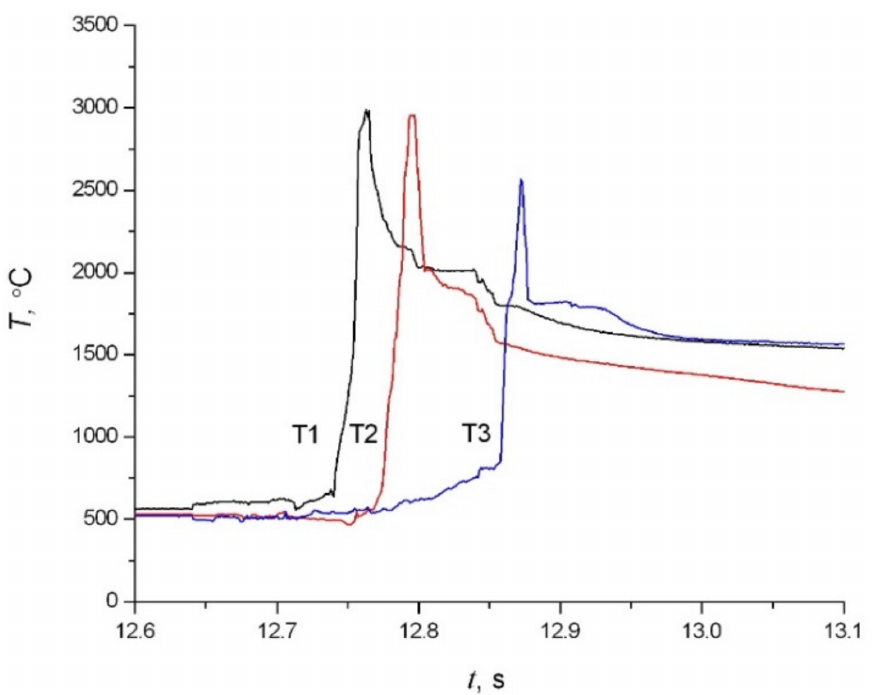
Figure 2. Readings of thermocouples T1–T3 during combustion of Set 1 (Figure 1 and Table 2).